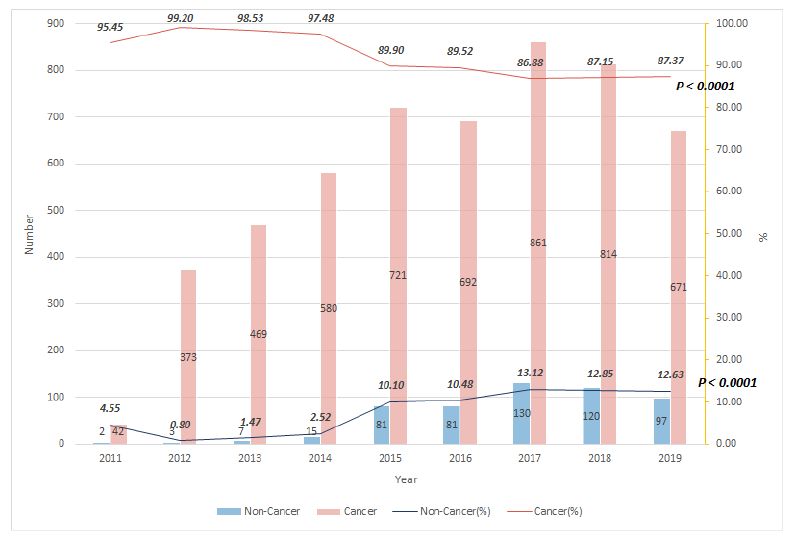
Figure 1. Trend of terminally ill cancer and non-cancer patients receiving PCCS from 2011 to 2019.